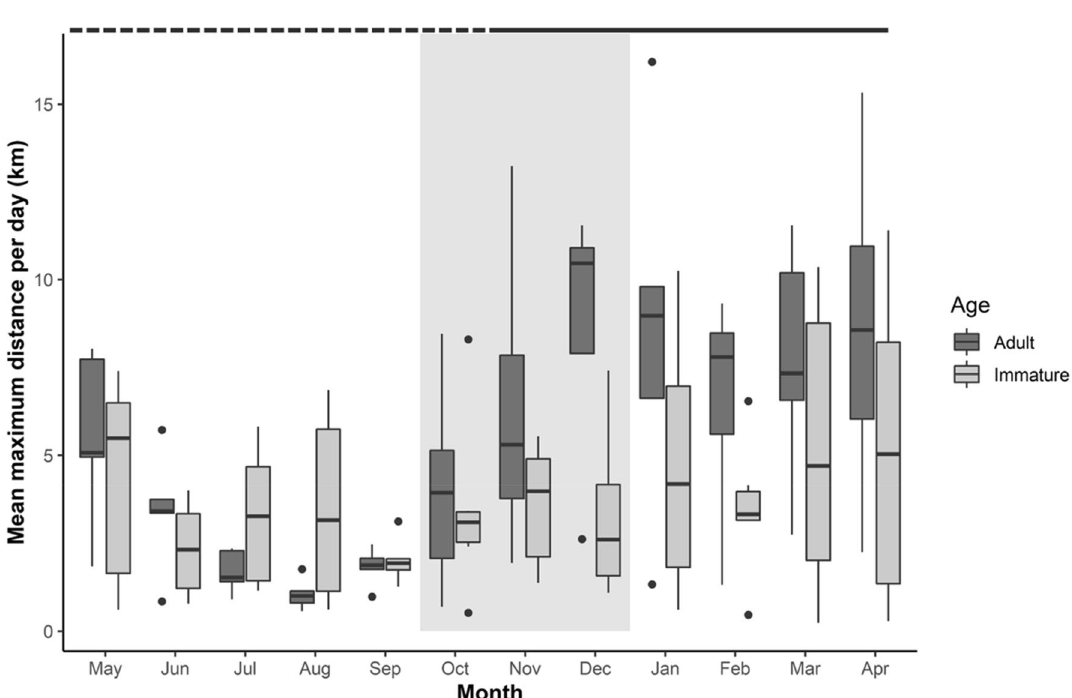
Figure 3. Boxplots of the mean maximum daily distance per month, for individual immature and adult Shoebills, between 2011 and 2018. Data is organised to start at the beginning of the breeding season (May). The boxes represent the 25th, 50th and 75th percentiles of the mean maximum daily distance. Whiskers show 1.5 times the value of inter-quantile range, with values outside this range plotted as black dots. The dashed line above the plot indicates the dry season (May to October) and the wet season (November to April). The shaded area highlights the period between October and December, with an increase of adult mean maximum daily